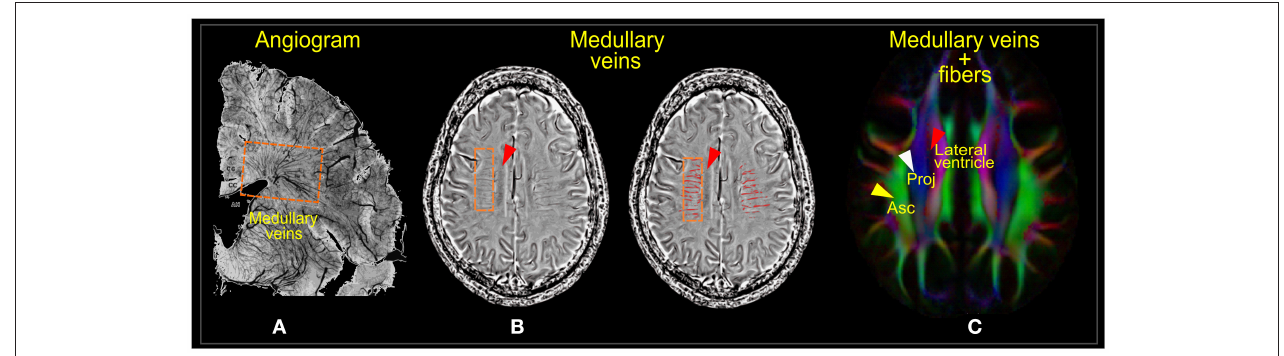
FIGURE 1 | Medullary veins. (A) Angiogram of the parenchymal venous system. (B) Phase images of susceptibility-weighted imaging (SWI) showing the deep medullary venous structures before (left) and after segmentation (right). (C) Diffusion tensor image showing the projection (Proj) and association (Asc) fiber areas where the medullary veins run. Images (A,B) were adapted, with permission from Yan et al. (31).